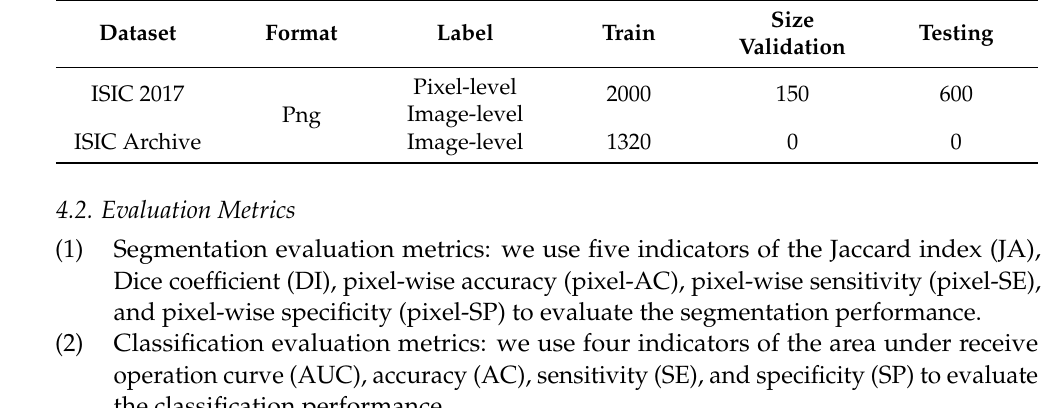
Table 2. Details of dataset ISIC 2017 and ISIC